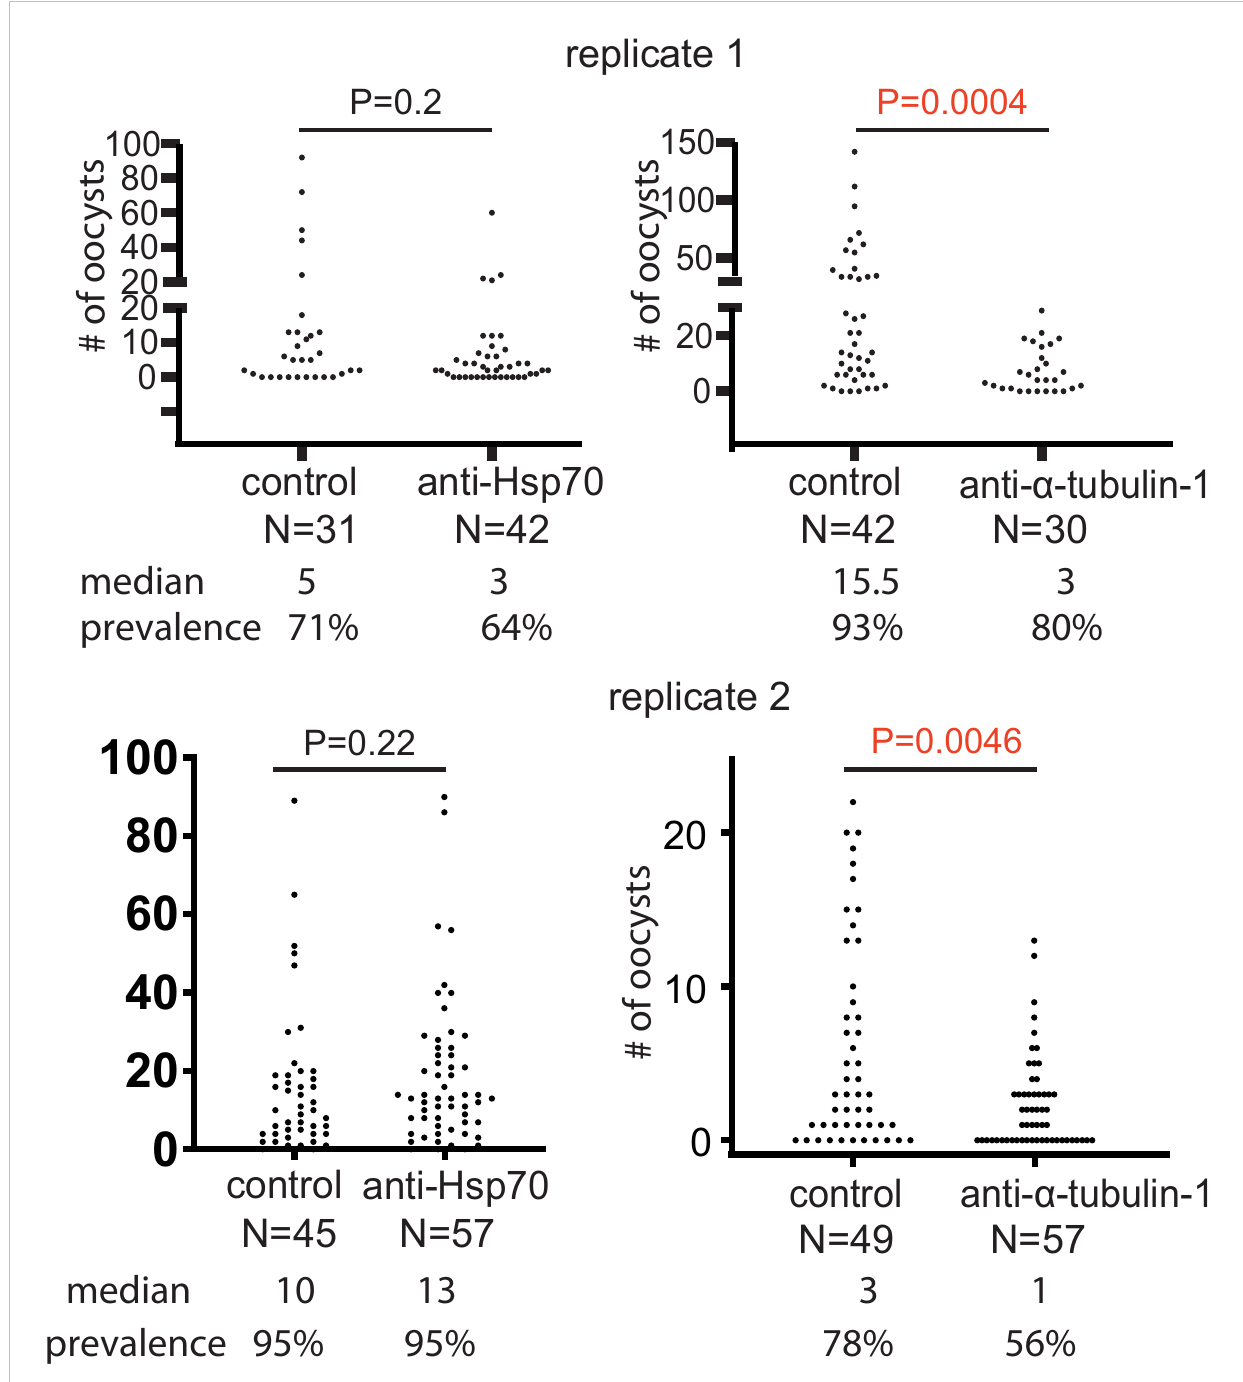
FIGURE 2 Anti- a -tubulin-1 antisera block P. falciparum transmission to An. gambiae . Infection intensity and prevalence of oocyst development in the presence of anti- a -tubulin-1 (titer: 1x10 5 ), anti-HSP70 (control, titer: 1x10 5 ), and the control (pre-immune serum) by standard membrane feeding assays. P values were calculated using the Mann-Whitney test. N, number of